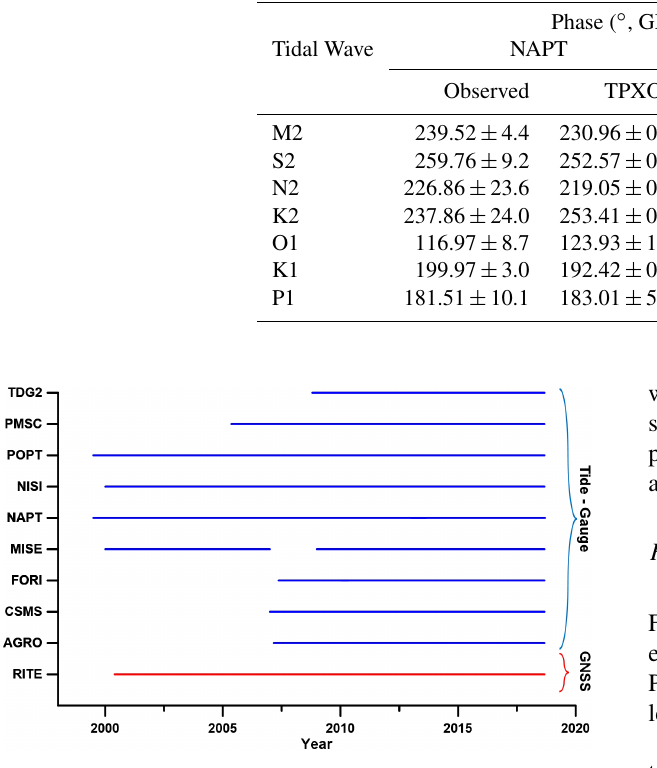
Table 3. Observed and predicted by TPXO9_v2a model phases of the main seven tidal components for NAPT and POPT.